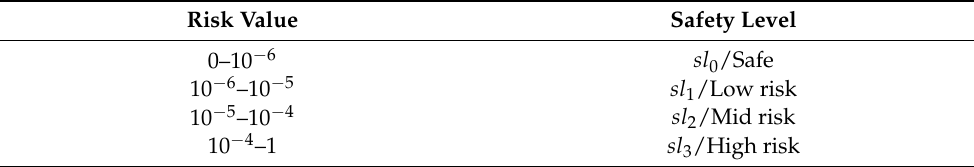
Table 2. Safety level